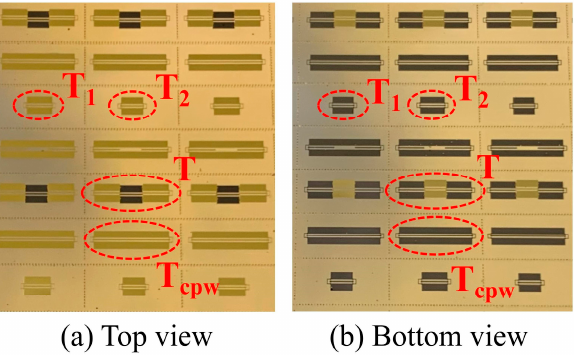
Figure 5. The CPW TGVs test structure prototype. ( a ) Top view and ( b ) Bo tt om view.